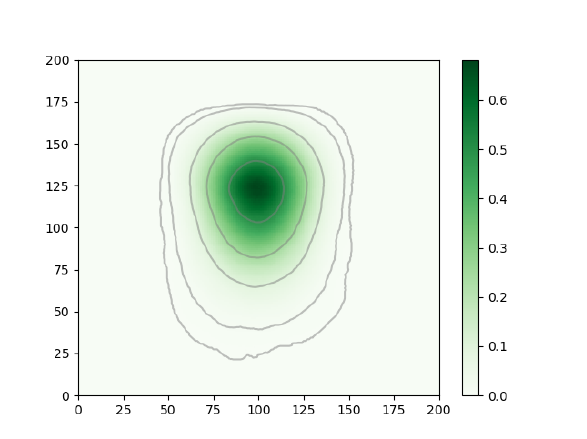
Figure 5. Section of a fuzzy pipe. The contour lines correspond to membership levels 0.001, 0.01, 0.1, 0.25,